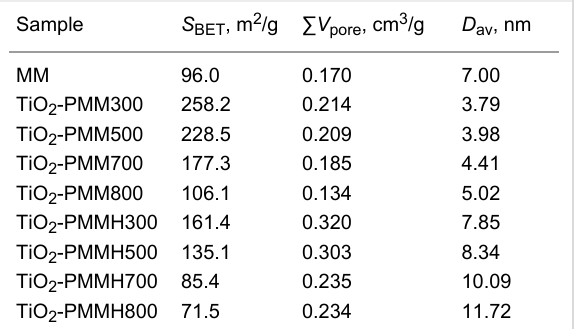
Table 5: Textural characteristics of TiO 2 -pillared MM samples. Sample